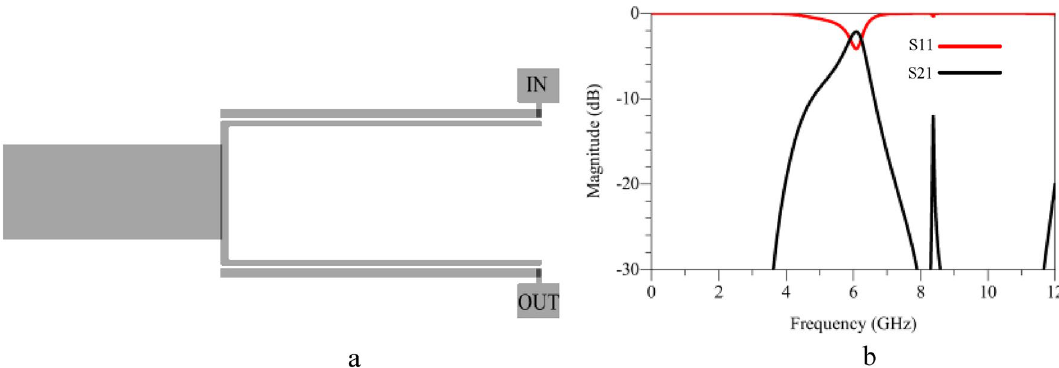
Figure 6. FR combining with rectangular stub: ( a ) Layout, ( b ) EM simulation.